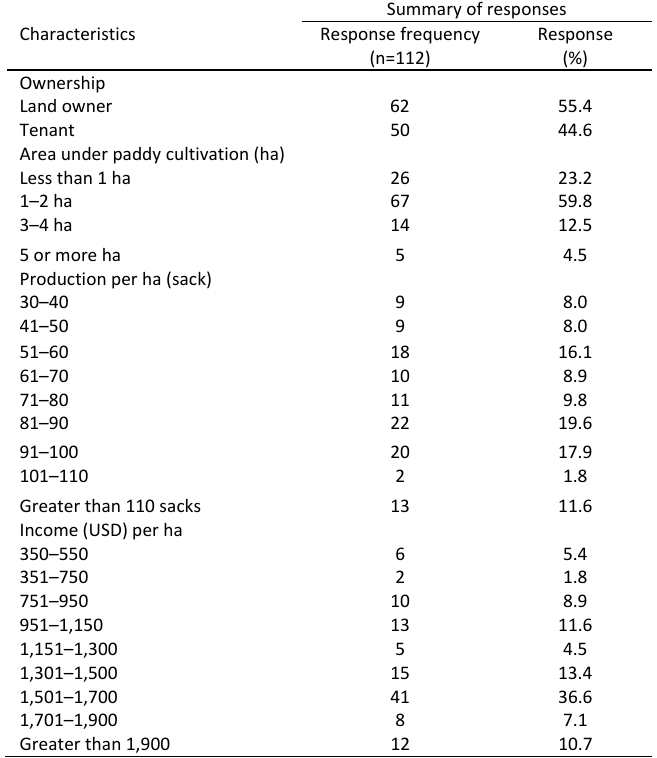
Table 2: Socioeconomic characteristics of farmers in the three barangays in North Cotabato